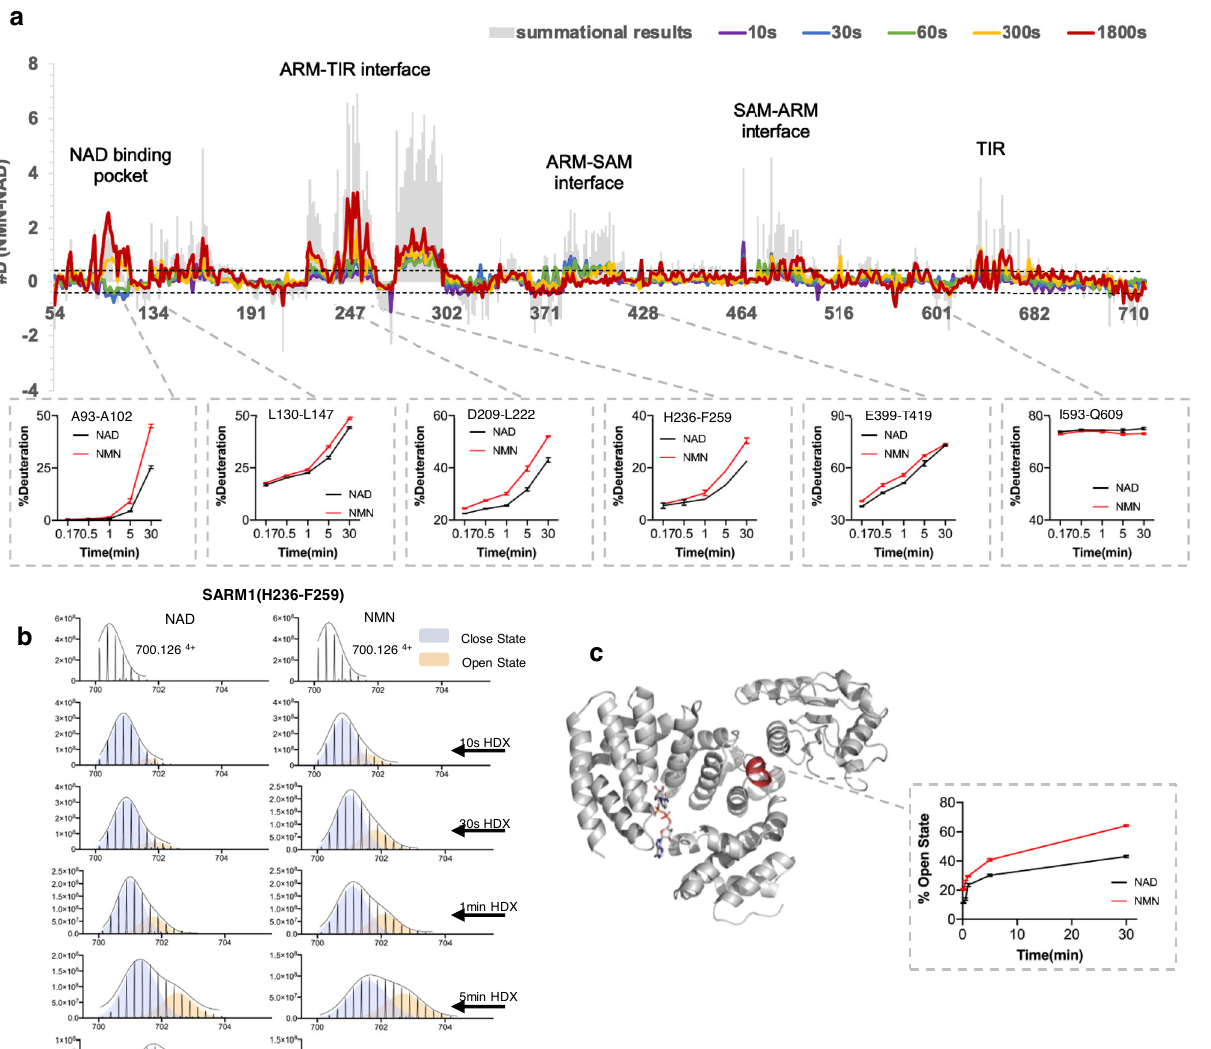
Fig.6 |HDX-MSrevealstheconformationaldynamicsofNMN-and NAD-bound SARM1octamersinsolution.a Plotrepresentingdifferencesindeuteriumuptake between NMN- and NAD-bound SARM1, with each data point representing the centralresidueofanindividualpeptide(orderedfromN-toC-terminus).TheY-axis represents the total difference in the number of deuterium uptake for a given peptide, between NMN and NAD bound SARM1 at each time point. Positive bars indicate anincrease in the exchange of the corresponding peptide in the presence of NMN and reveal that several distinct regions are affected by ligand binding. Horizontal dotted lines represent the threshold above which deuterium uptake differences were considered signi fi cant (>0.4Da). HDX data statistics is given in SupplementaryTable1,anddetailsareinSupplementaryData1.TheTimecourseof